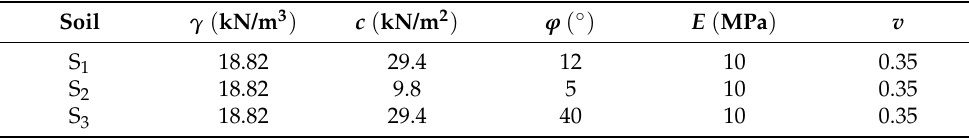
Table 2. Mechanical Parameters of Section